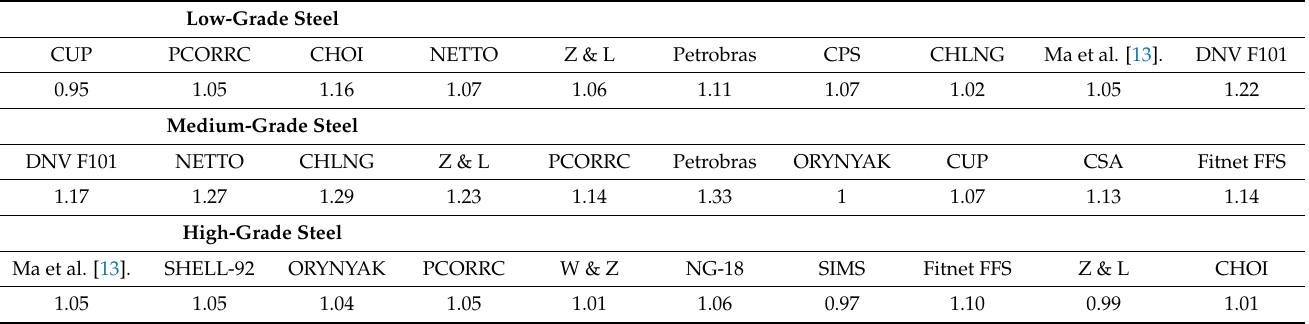
Table 4. Strength factors ( X r ) for the 10 top models in three categories at T o